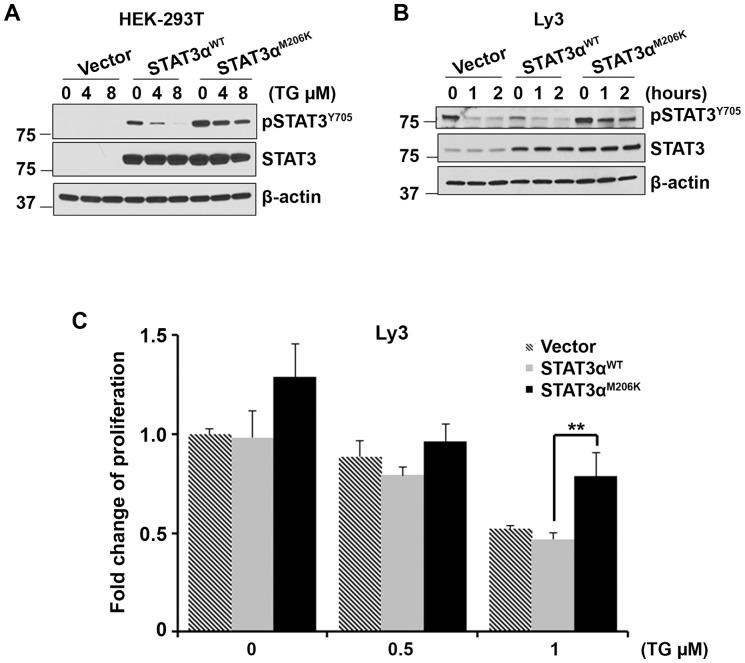
The effect of STAT3α M206K mutation on the sensitivity of DLBCL cells to JAK2 inhibitor TG101348.(A–B) The effect of JAK2 inhibitor TG101348 on STAT3 dephosphorylation was assessed in WT STAT3αWT and mutant STAT3αM206K in stably transfected HEK-293T cells (A) and transiently transfected Ly3 cells (B). Data were repeated three times. (C) The effect of the overexpression of WT STAT3αWT and mutant STAT3αM206K on cell proliferation in the presence or absence of JAK2 inhibitor TG101348. Bars represent mean ± SD from 4 replicates. The experiment was repeated two times (**P = 0.0023). The data were analyzed by the two-tailed unpaired Student's t test.